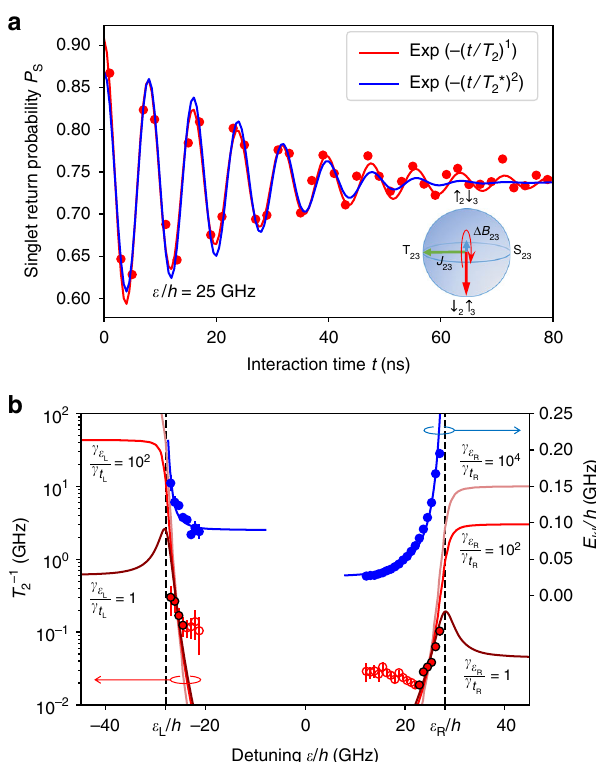
Fig. 5 Markovian dephasing measurement of the three-spin system. a Exchange oscillation (SWAP) between σ 1 " 2 # 3 j i and σ 1 # 2 " 3 j i driven by a brief excursion to ε / h = 25 GHz for the duration of t , following the adiabatic loading of σ 1 # 2 " 3 j i (Methods section). Red and blue lines are the fi ts to the (cid:3) decaying oscillations A exp (cid:3) t = T ð(cid:7)Þ 2 ( a = 1 with the dephasing time T 2 ) and Gaussian ( a = 2 with the emsemble dephasing time T 2 * ) envelopes, respectively. b The dephasing (red circles) and the oscillation frequency E kl / h (blue circles) rate T (cid:3) 1 2 extracted from the fi ts as in a with the exponential envelope at various ε with the error bars representing the standard errors of the fi tting. Blue lines represent energy gaps for E 21 and E 32 calculated with the same parameters as those used in Figs. 2 and 4 except for Δ B 12 / h = 90.5 MHz and Δ B 23 / h = 26.7 MHz determined by the fi tting. Those values differ from the ones derived in Fig. 4 due to the slow Overhauser fi eld fl uctuation. Red lines are the dephasing rates Γ 12 and Γ 23 arising from the charge noise modeled by = γ Eq. 1 for different magnitudes of γ ε . The values of γ t and γ t used in t L ; R L ; R L R = γ ¼ 100. Figs. 3b and 4c are derived from the fi tting by choosing γ ε t L ; R L ; R The data points with red empty circles deviate from the model because the fl uctuation of Δ B ij also contributes to the Gaussian decay and a fi tting with an exponential envelope is unreliable in the corresponding detuning